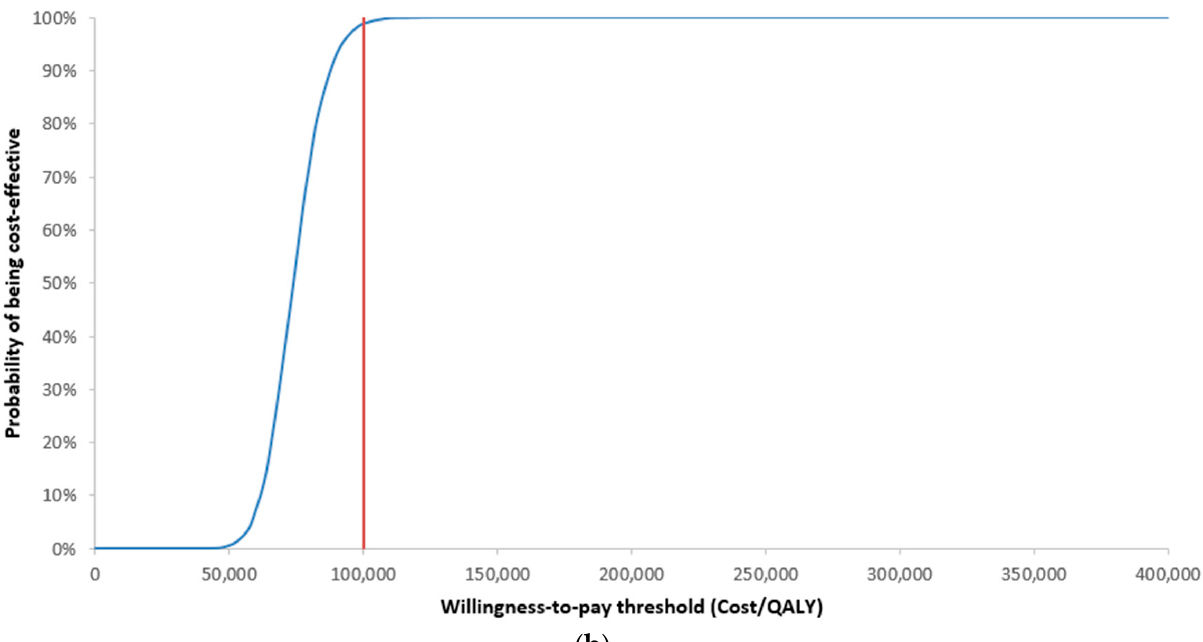
Figure 3. Results of the probabilistic sensitivity analysis from an MoH perspective presented as a ( a ) scatter plot and ( b ) cost ‐ effectiveness acceptability curve, QALY: quality ‐ adjusted life year.